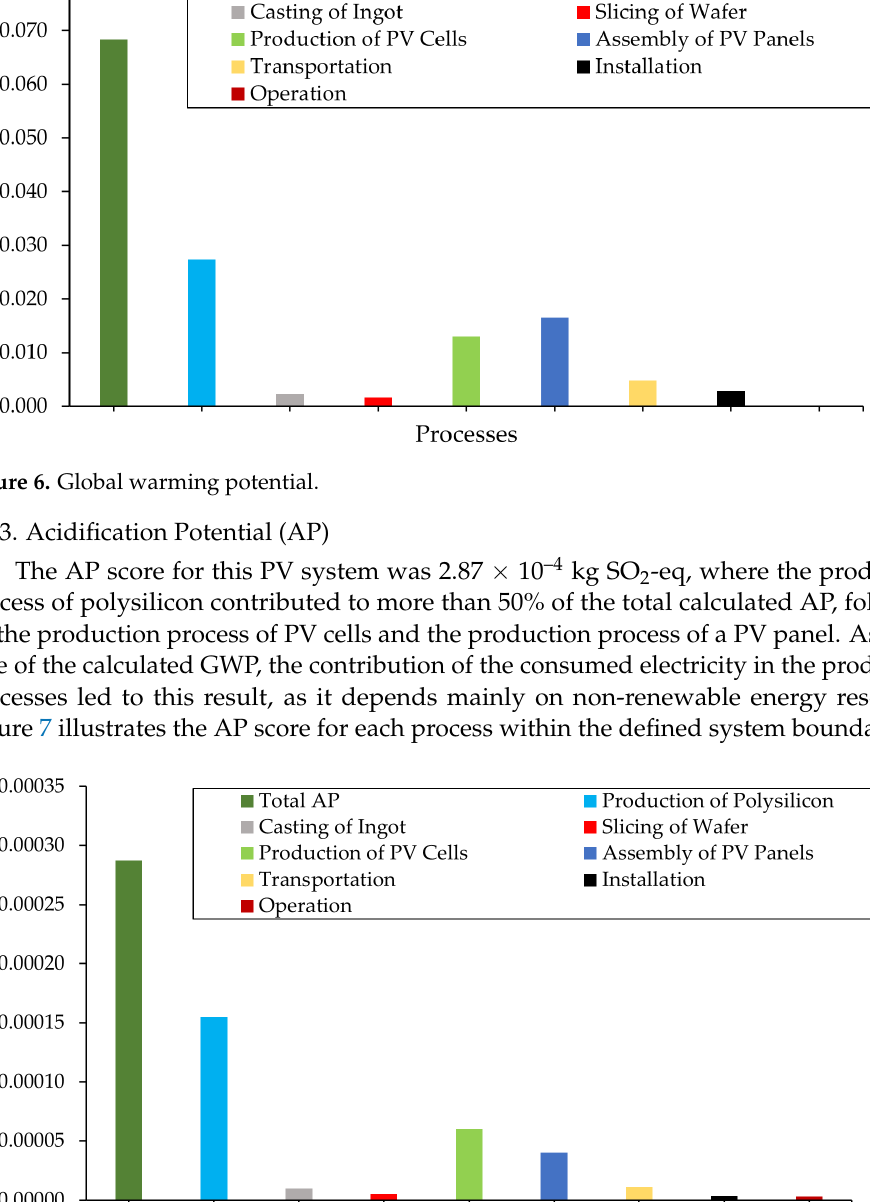
Figure 8. Eutrophication potential . 4.1.5. Ozone Layer Depletion Potential (ODP) The ODP score for this system was 4.685 × 10 –9 kg CFC-11-eq., the most influential process in this score was the production of a PV panel, which contributed to more than 70% of the total ODP score, followed by the production process of polysilicon, which con- tributed to approximately 20% of the total ODP, while other processes had an insignificant impact. This was mainly due to the production process for the aluminum frame of the PV panel and the consumed electricity during the whole production process, which is origi- nally generated from non-renewable energy resources. Figure 9 represents the ODP score for each process within the defined system boundary.